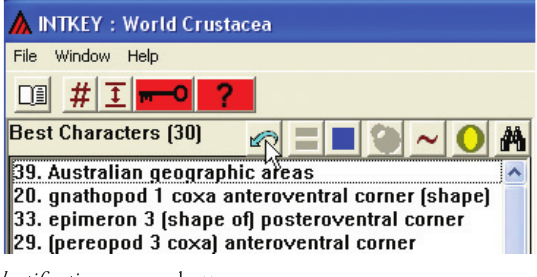
Figure 42. Restart identifi cation or query button.